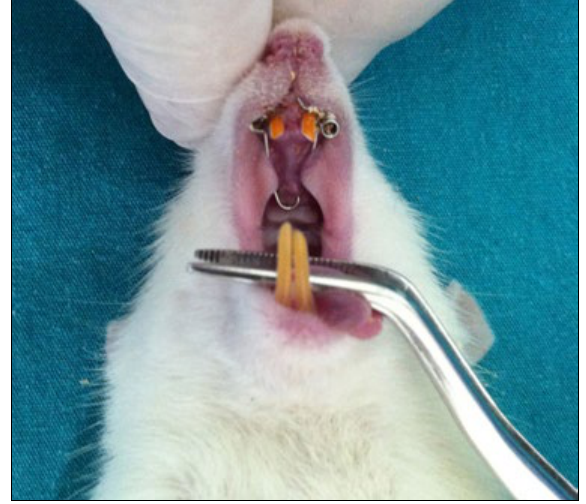
Figure 2. Intra-oral view of the expansion